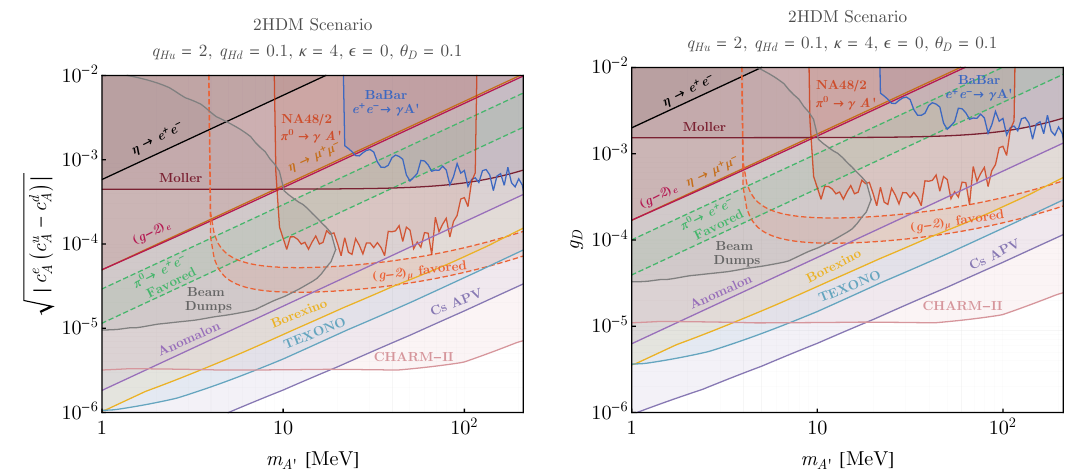
Figure 3 . Representative constraints on the parameter space for the 2HDM realization of axial couplings. The left panel plots the e(cid:11)ective coupling for pseudoscalar decay the right panel plots the gauge coupling g D